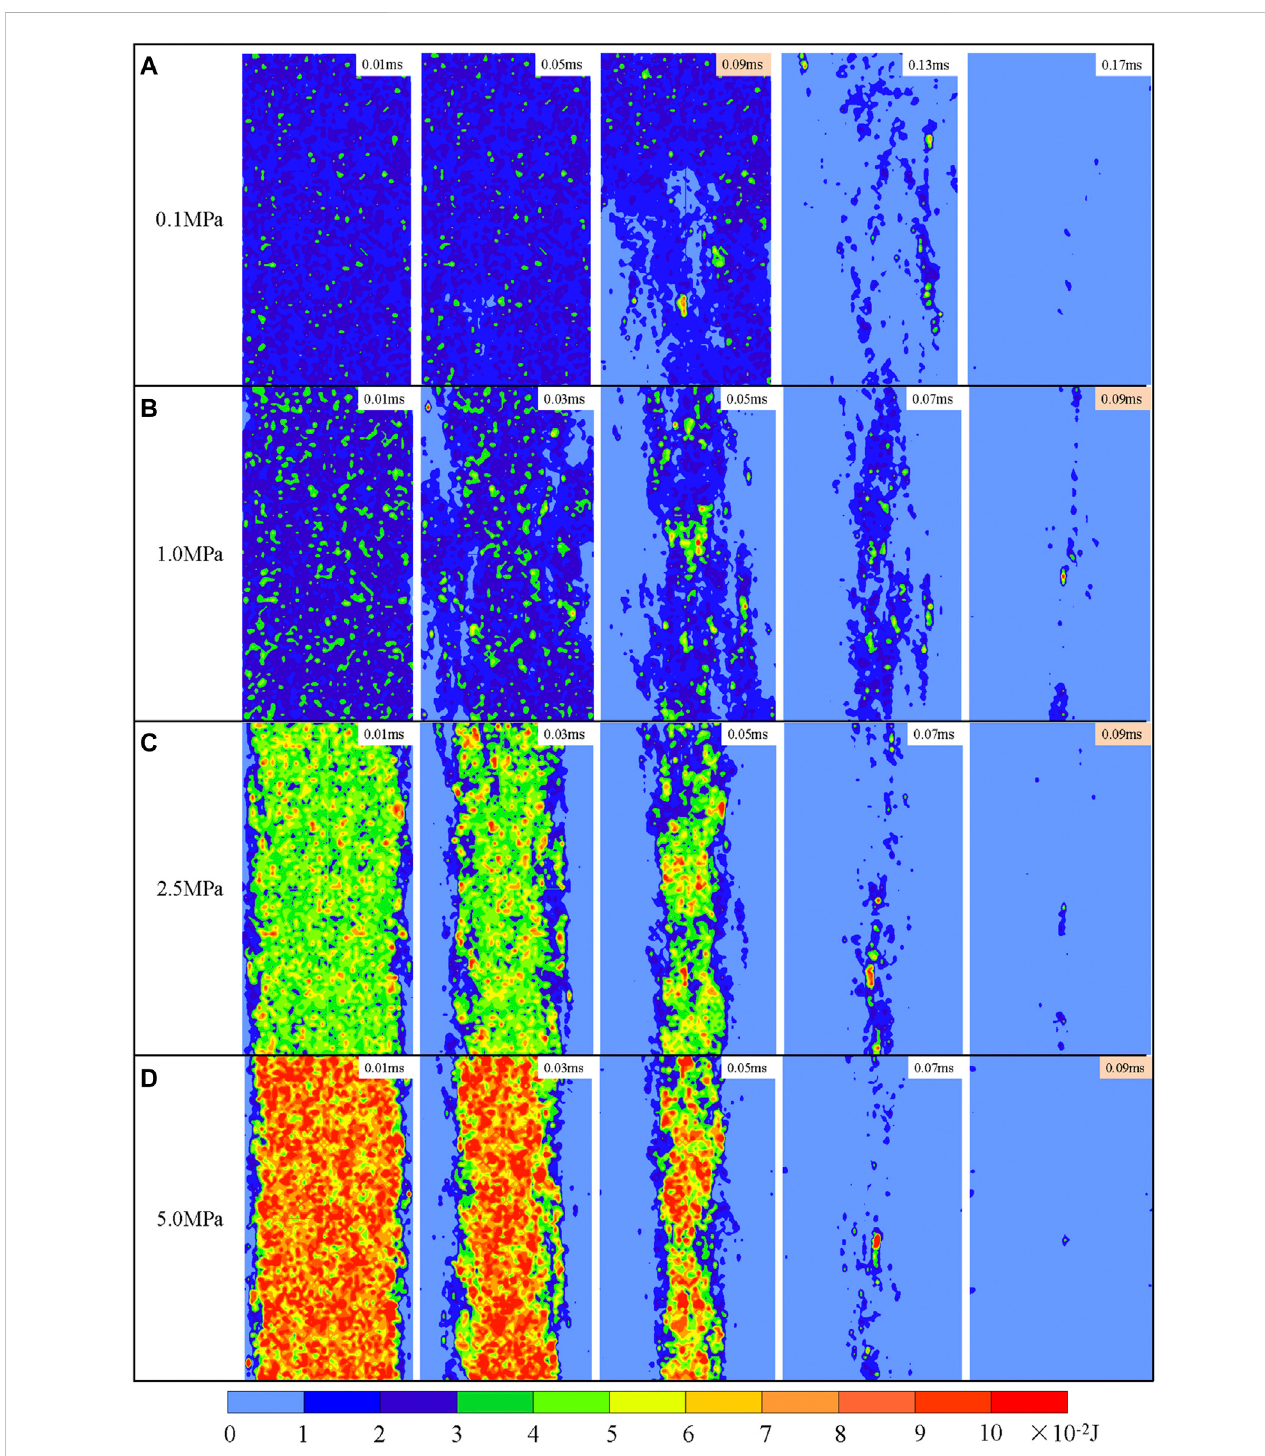
FIGURE 8 Distribution of elastic energy under different pre-con fi ning pressures: (A) .1 MPa; (B) 1 MPa; (C) 2.5 MPa and (D) 5 MPa for different points in time.